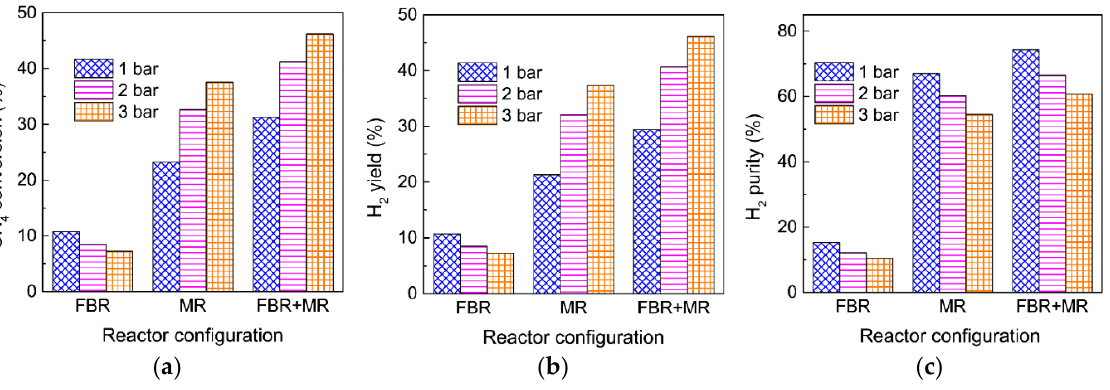
Figure 10. Effect of reactor configurations on ( a ) CH 4 conversion, ( b ) H 2 yield, and ( c ) H 2 purity for MDA in the membrane reactor with different CH 4 feed pressures. (Simulation conditions: Temperature = 973 K, catalyst amount = 0.15 g, CH 4 feed = 6.59 × 10 − 3 mol h − 1 , H 2 permeance = 72 mol m − 2 h − 1 bar − 1 , membrane length = 0.4 m, membrane diameter = 2.5 × 10 − 3 m, α CH = Knudsen selectivity, p l = 0.05 bar, and p h = 1, 2 and 3 bar). 4 / C 6 H 6